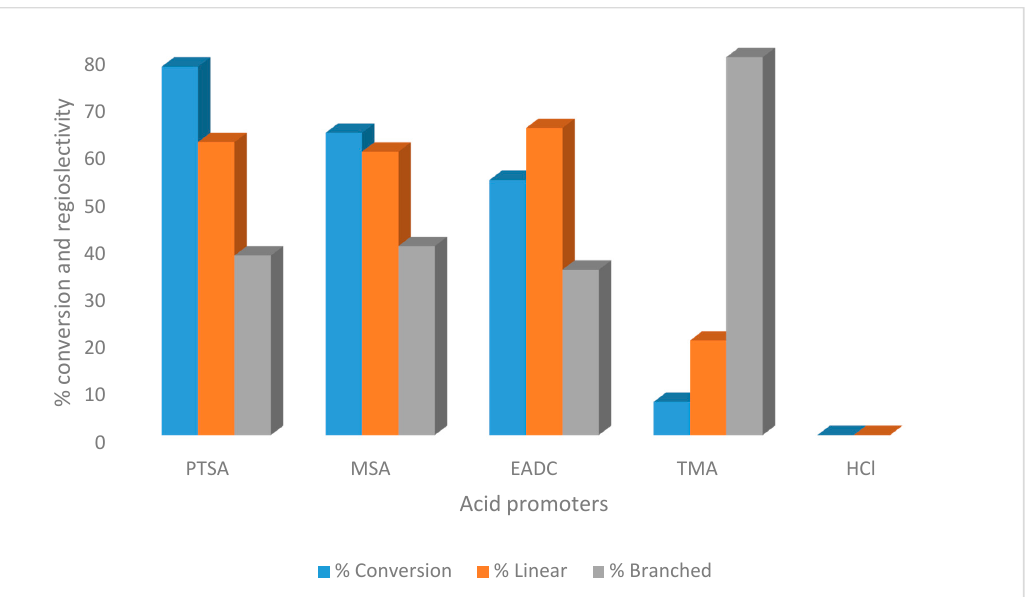
Figure 2. The effect of the acid promoters in the methoxycarbonylation of 1-hexene using complex 2 at a 1-hexene:HA:PPh 3 : 2 ratio of 200:10:2:1 and with 1-hexene (2 mL, 16.00 mmol), P CO , 60 bar; temperature 90 ° C; time 24 h; and the solvent as methanol/toluene (100 mL).